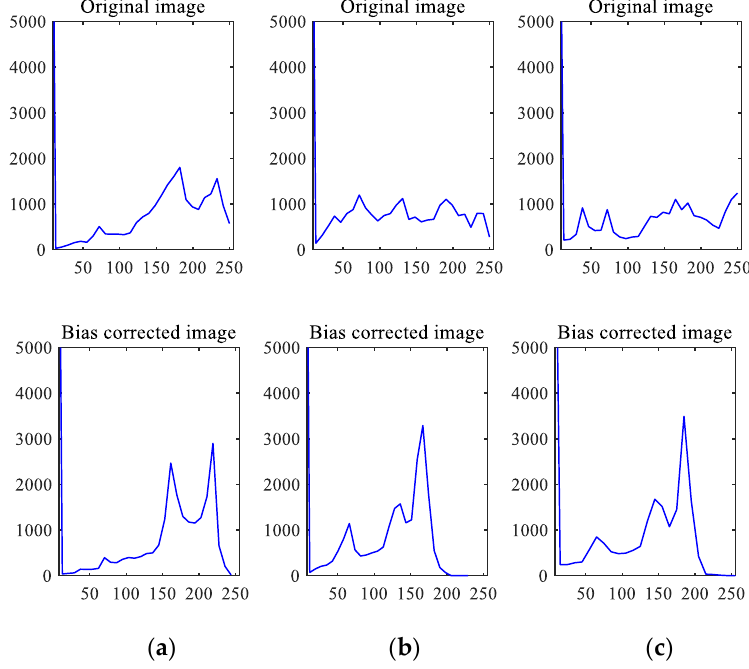
Figure 6. The histograms of the original and bias field correction images: ( a ) the histogram of axial-sectioned images; ( b ) the histogram of sagittal-sectioned images; and ( c ) the histogram of coronal-sectioned images.